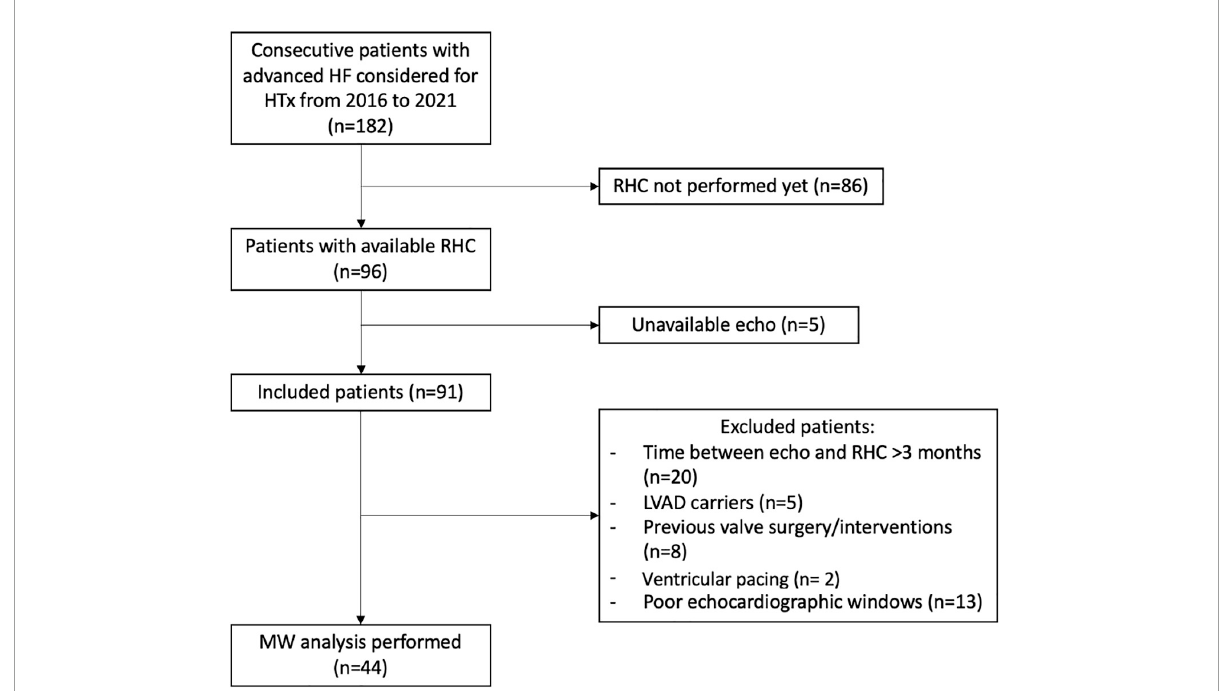
FIGURE1 Study flow chart. Inclusion and exclusion criteria as well as patients eventually included in the analysis are reported. HF, heart failure; HTx, heart transplant; RHC, right heart catheterization; LVAD, left ventricular assist device; MW, myocardial